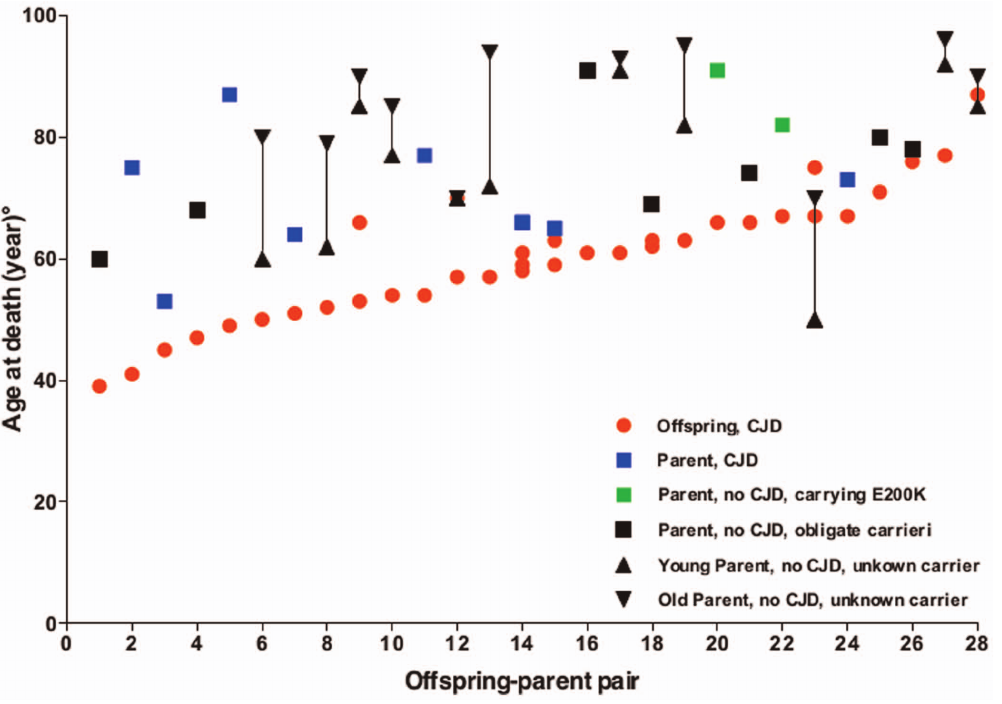
Figure 1. Parent-offspring pairs in the study population. Black circles, offspring with CJD; black squares, parents with CJD; black and white squares, unaffected parents carrying the E200K PRNP mutation; white squares, unaffected parents who are obligate carriers for the E200K PRNP mutation; white triangles, the oldest (up) and youngest (down) unaffected parents where it was unfeasible to discriminate the carrier. Vertical bars link the age between the oldest and youngest unaffected parents where it was unfeasible to discriminate the